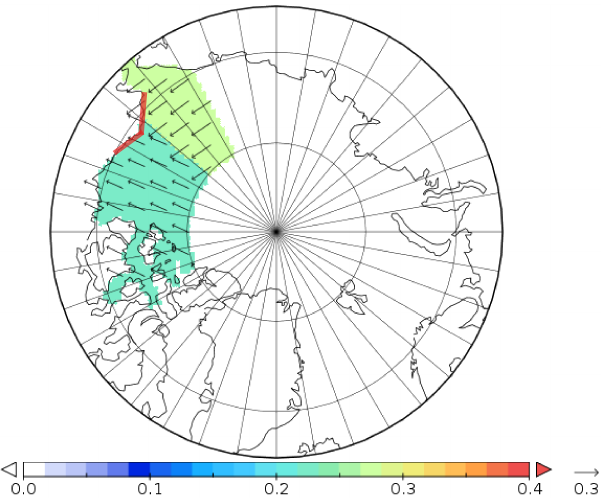
Figure 8. Wind stress direction with highest impact of tau compo- nent in control vector on ice thickness in BS2PB target region (dark red colour). Colour indicates magnitude.